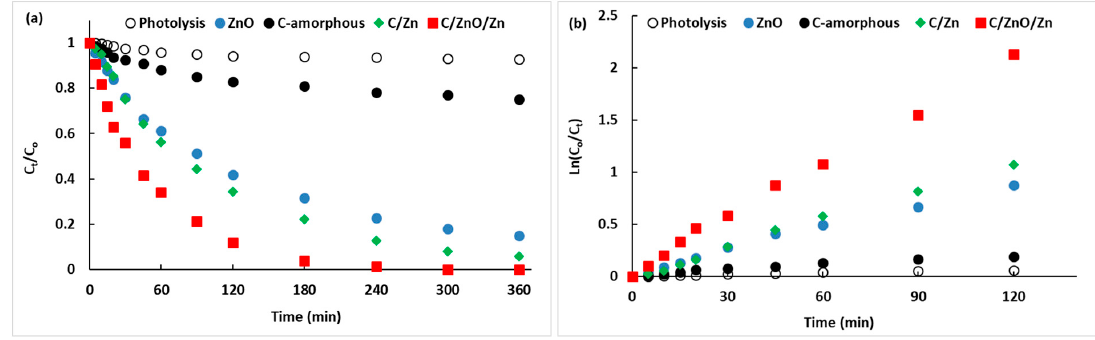
Figure 6. ( a ) Kinetic of BB41 photodegradation under artificial solar irradiation; ( b ) linear regression of the kinetic data from Figure 6a.